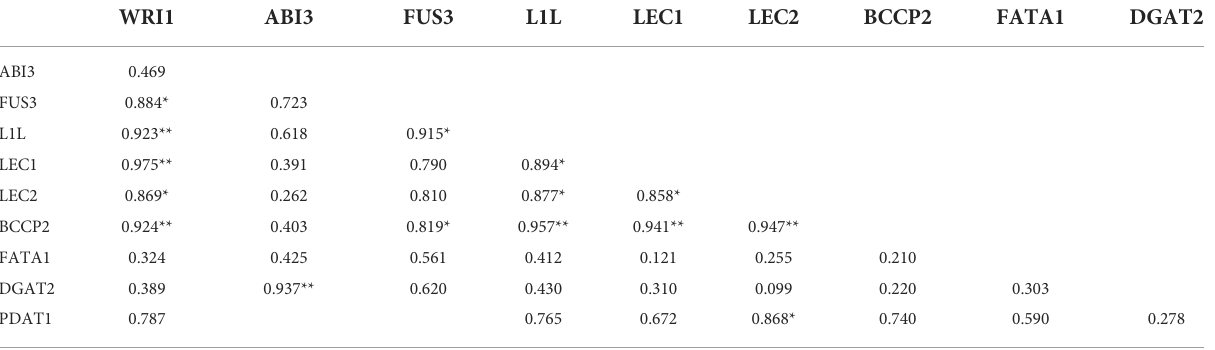
TABLE 2 Pearson ’ s correlation analysis between expression levels of WRI1 and expression levels of related